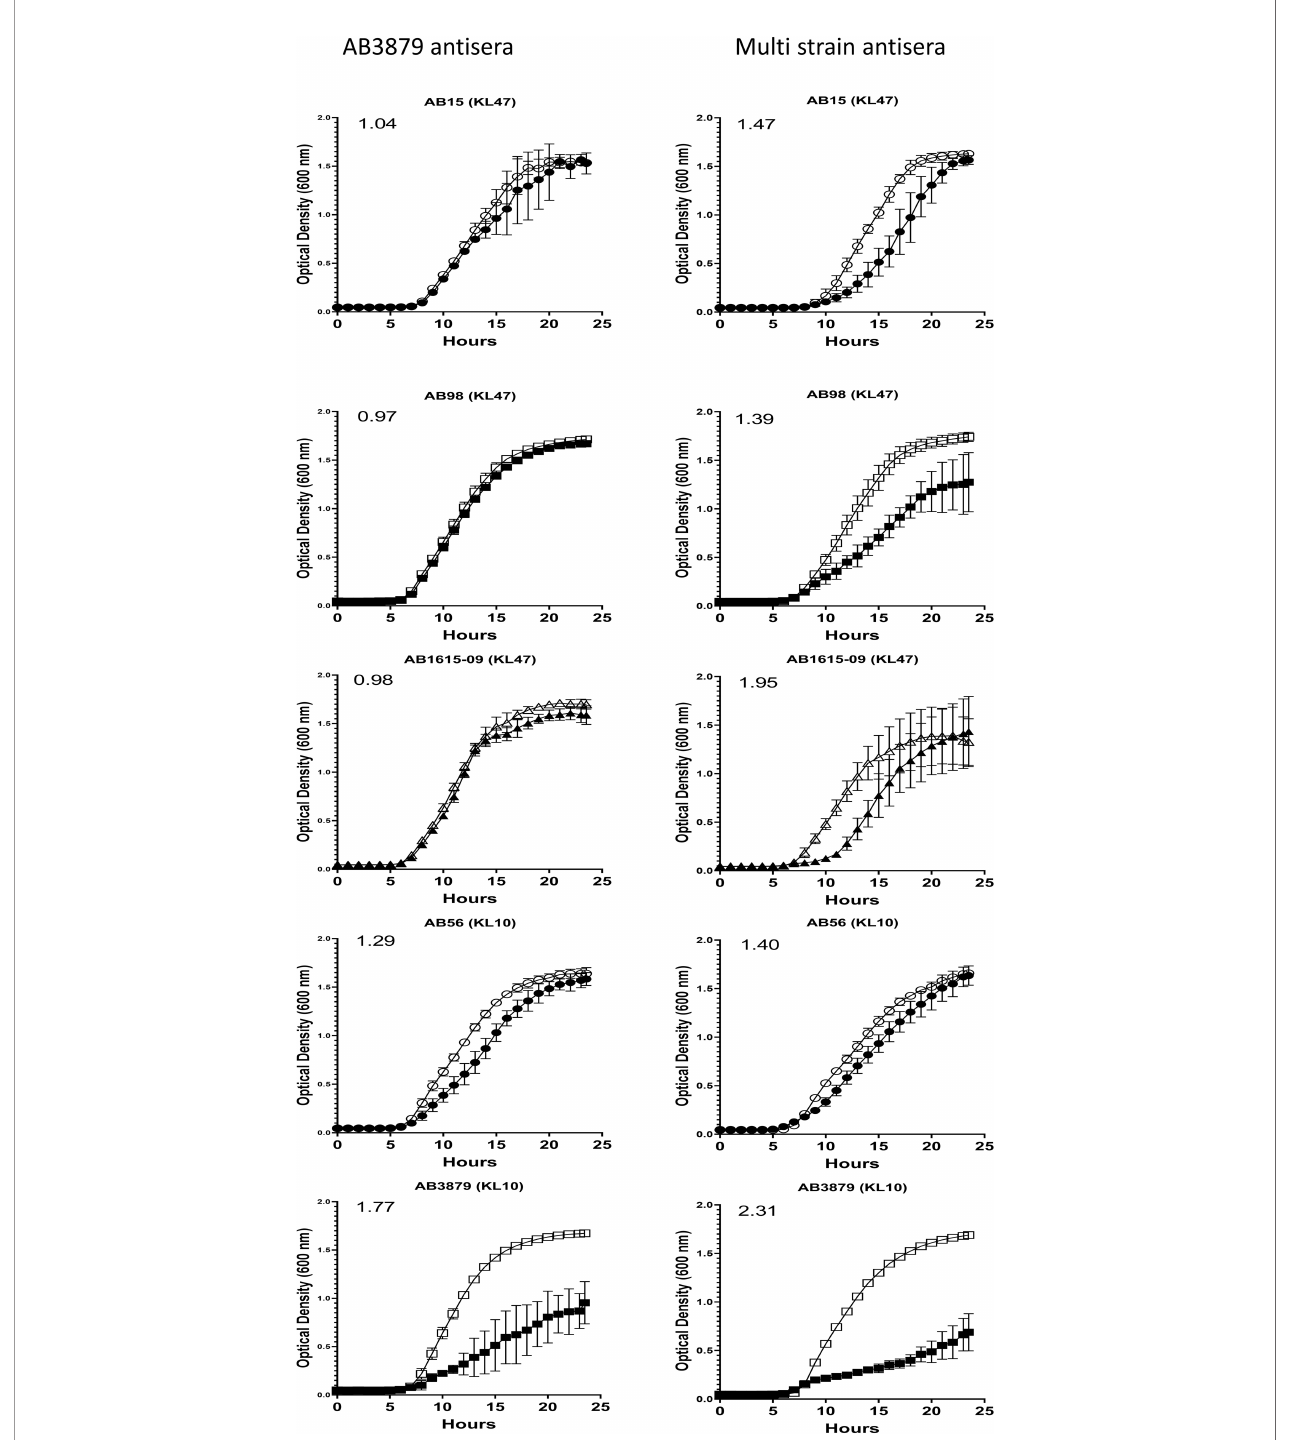
FIGURE 6 | Growth inhibitory activity ona panel of fi ve A. baumannii isolates by mouse antisera. 10 2 CFUofa panel of A. baumannii isolates were incubated in triplicate with either AB3879 antisera (leftpanel)or multi strain antisera (right panel)and the OD 600nm measuredevery 30 minutes for 24 hours. Sera from non-immunizedmice was included as a control (open symbols).Solid symbols represent respective anti- A. baumannii antisera. The fi ve isolates are grouped bytheir capsule serotype and indicated at the top of each graph in brackets. Round,square and trianglesymbolsrepresent ST2, ST215, and ST164 MSLTtypes respectively. Numberson the top left-handcorner represent the ratios of doublingtime for respective antisera. Ratios ofdoublingtime intest sera/control sera were calculated with a ratioof > 1.2 indicating delayed growth in the antisera. Line graphs indicate the mean value, and the error bars indicate standarddeviations (SDs) (n =